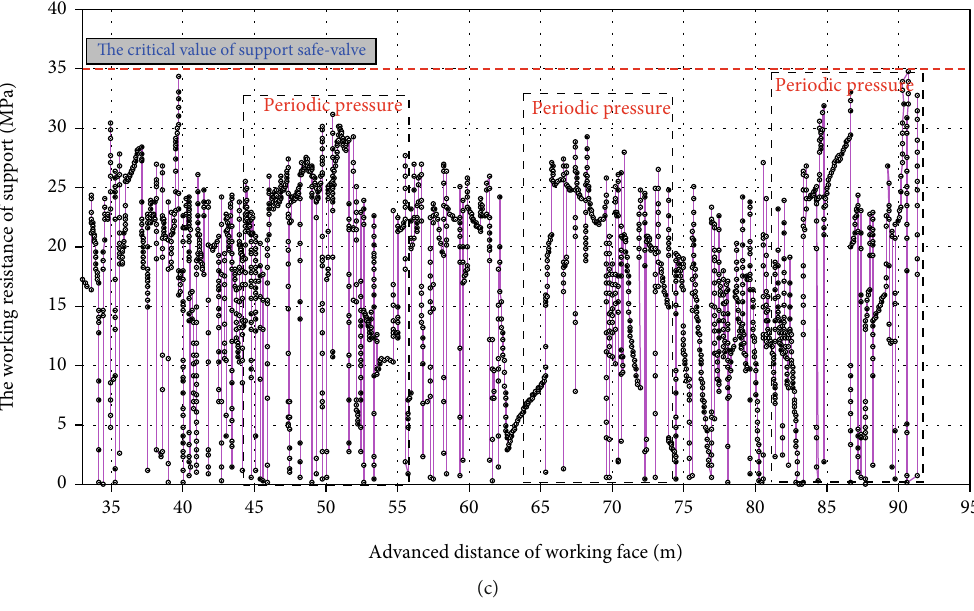
Figure 9: Working resistance of three hydraulic supports during the periodic weighting of main roof. (a) The working resistance of the No.3 measuring point (uncut side). (b) The working resistance of the No.2 measuring point (middle area). (c) The working resistance of the No.1 measuring point (roof